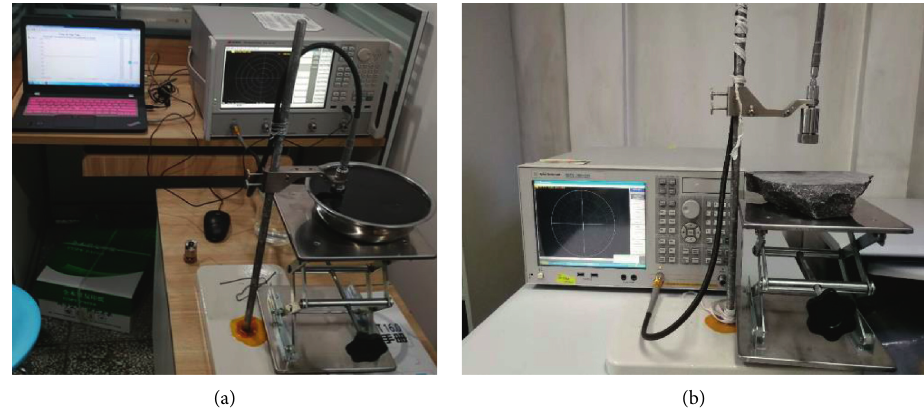
Figure 2: Single-phase material measurement process.